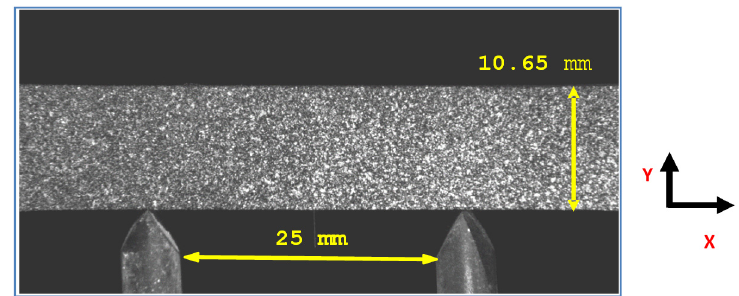
Figure 4. Sprayed speckle pattern and image scale.